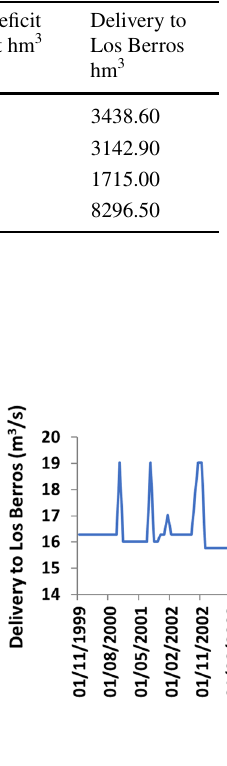
Table 11 Spills and deficits with genetic algorithm GA3 policy